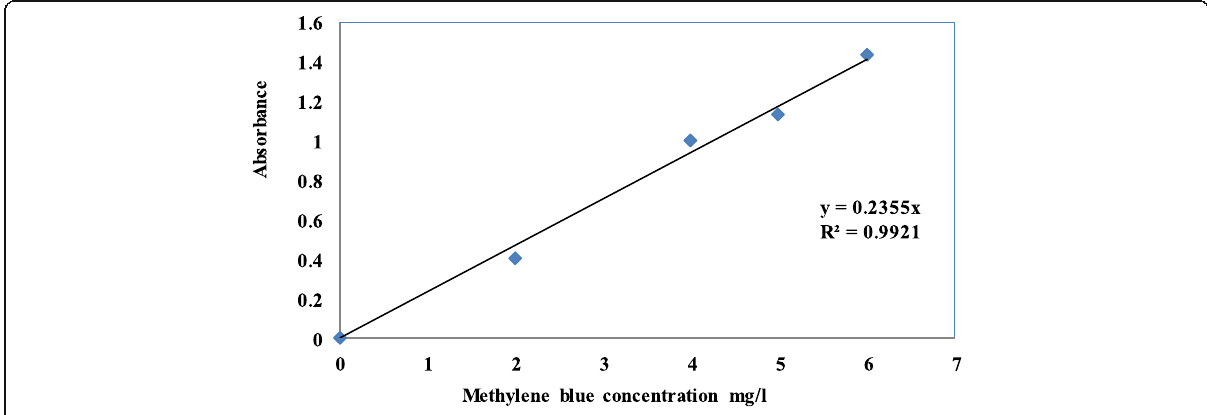
Fig. 3 Variation of MB dye concentration with absorbance ( ƛ max = 660 nm)